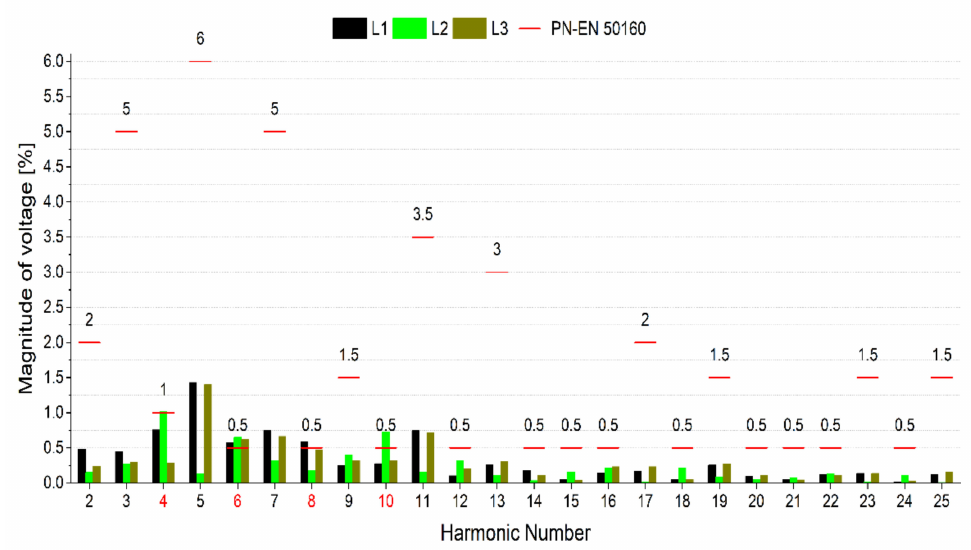
Figure 11. Voltage harmonic spectrum (95th percentile) for one electric bus charging